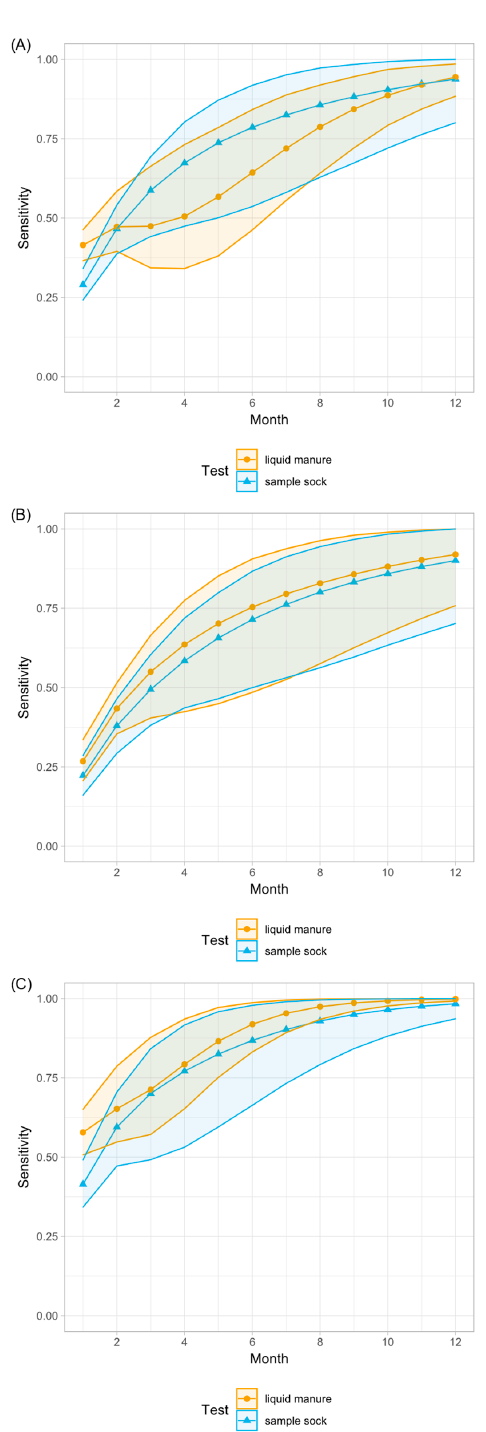
Figure A1. Cumulative sensitivity and 95% credible interval (CI) of sample sock and liquid manure for the detection of Mycobacterium avium subsp. paratuberculosis (MAP). ( A ) Model run with the data of all study herds. ( B ) Model run with the data of all MAP-free herds (group 0) and all MAP-infected herds with a within-herd prevalence of MAP-shedders of less than 2% (group 1). ( C ) Model run with the data of all MAP-free herds (group 0) and all MAP-infected herds with a within-herd prevalence of at least 2% (group